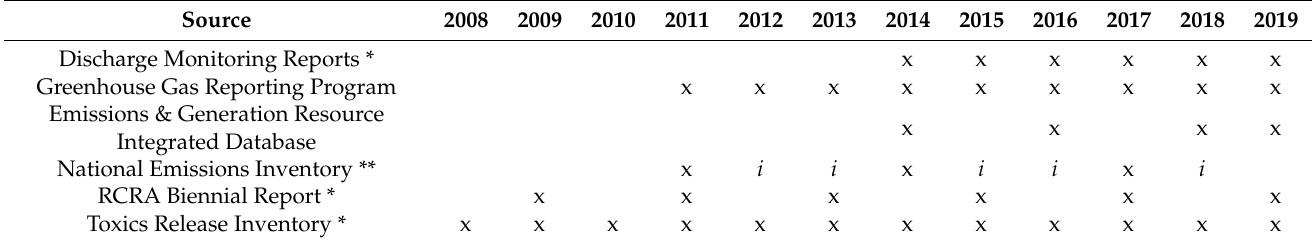
Table 7. USEPA inventories accessible by